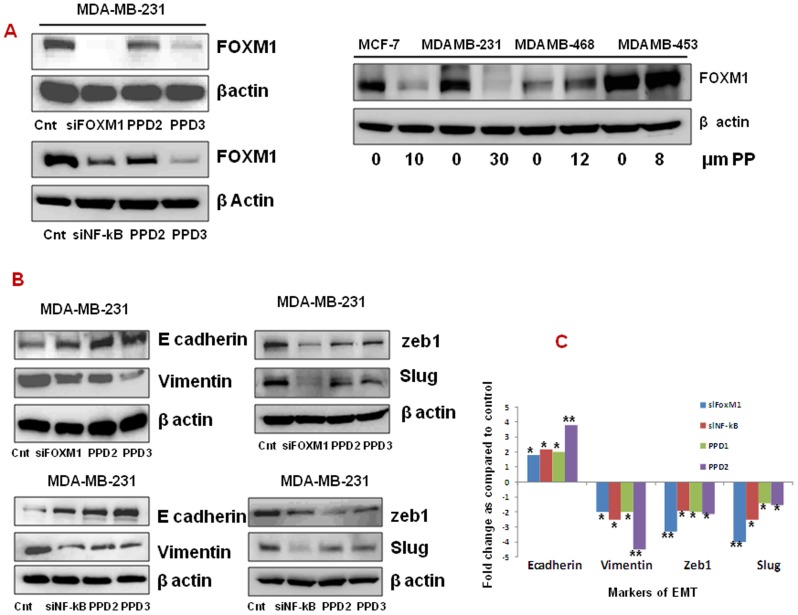
Panepoxydone modulates EMT related markers.Total protein was isolated from control and PP-treated breast cancer cells and subjected to immunoblotting of proteins. Membranes were stripped and re-probed with anti-actin antibody to ensure equal protein loading. (A) Immunoblotting of FOXM1 after PP treatment and silencing of FOXM1 and NF-κB. (B) Immunoblots of cell lysates treated with PP or silenced FOXM1 and NF-kB for E cadherin, vimentin, slug and zeb-1. (C) Bar diagram indicate the fold difference in the EMT markers after PP treatment and above specified silencing. * indicates statistically significant difference between PP treated and untreated cells at p<0.05 (*) and p<0.01(**) levels by student's t-test. Altogether this data indicate the PP induced EMT reversal is through FOXM1 in breast cancer cells.